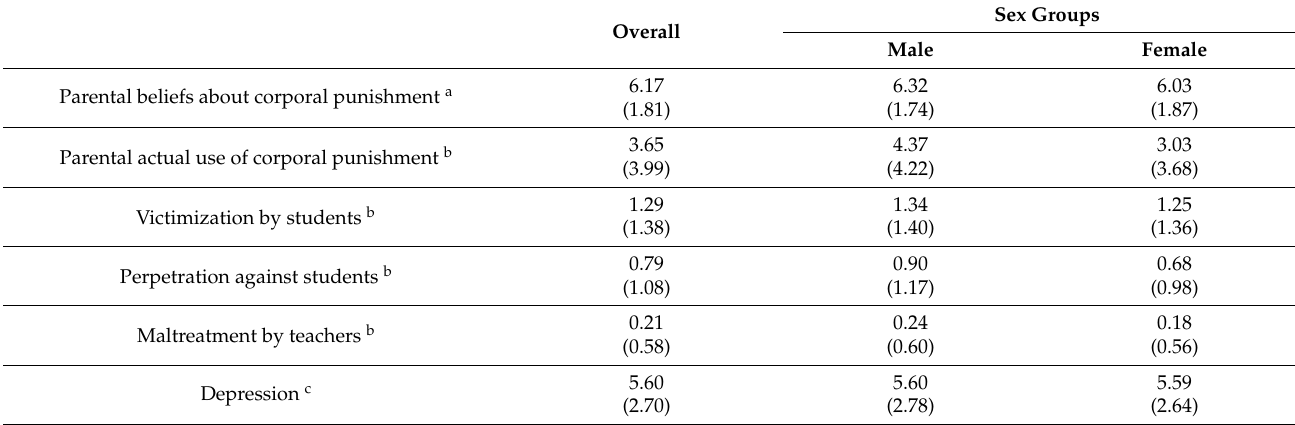
Table 1. Means and standard deviations of each scale by sex groups (standard deviations in